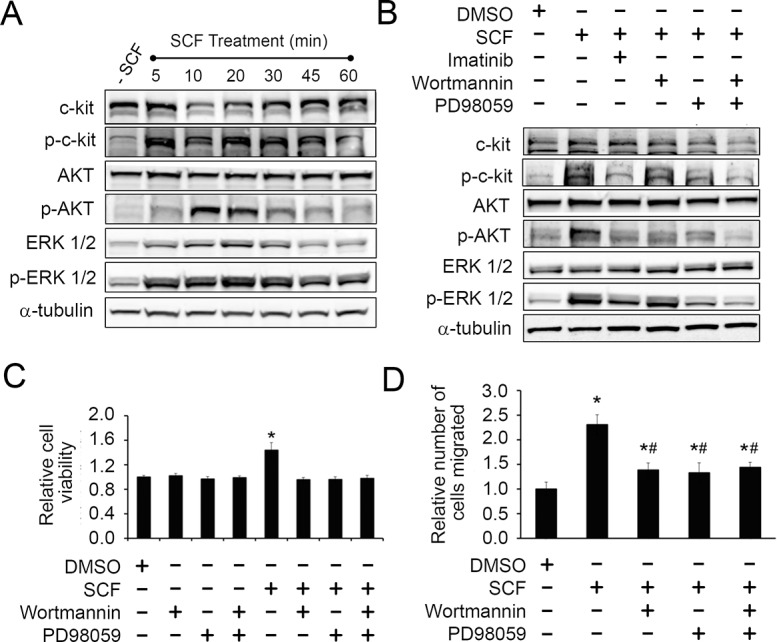
The effects of c-kit activation on CPCs are mediated via the PI3K-AKT and the MEK-ERK pathways.A, Human c-kit+ CPCs were either untreated (- SCF) or treated with 100 ng/ml SCF for the indicated duration. Levels of the indicated proteins at each time point were analyzed by Western blot. p-, phosphorylated (i.e., activated) form. B, CPCs were pre-treated with the indicated inhibitors for 2 hr followed by 20 min of SCF treatment. Levels of the indicated proteins were analyzed by Western blot. Imatinib, a c-kit inhibitor; Wortmannin, a PI3K inhibitor; and PD98059, a MEK inhibitor. C, Cell viability assay. CPCs were cultured in serum-free medium for 3 days in the presence (+) of absence (-) of SCF and the indicated inhibitors. Cell viability was assessed using PrestoBlueTM. D, Boyden chamber assay for cell migration. CPCs were plated in the transwells. After 24 hr, they were pre-treated with the inhibitors for 2 hr, and SCF was then added to the bottom chamber. Migrated cells were fixed, stained with propidium iodide, and counted. All values are normalized to the DMSO (vehicle) control. Values presented are mean ± SEM. *, p<0.05 compared to the DMSO control. #, p<0.05 compared to the SCF only treatment group.